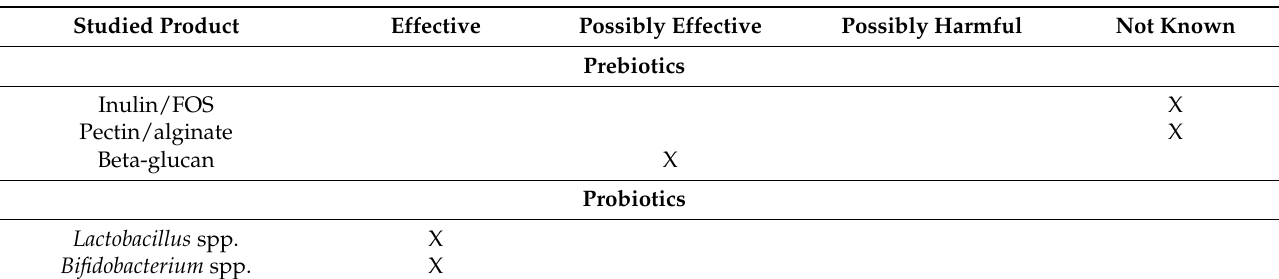
Table 2. Gut microbiota modulation and sport